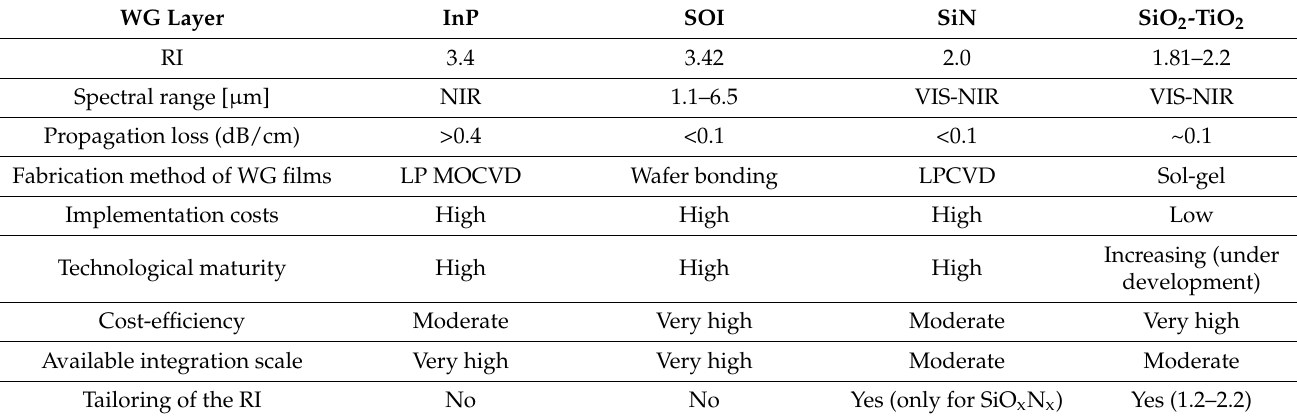
Table 1. Comparison of developed SiO 2 -TiO 2 integrated photonics technology with InP, SOI and SiN technologies